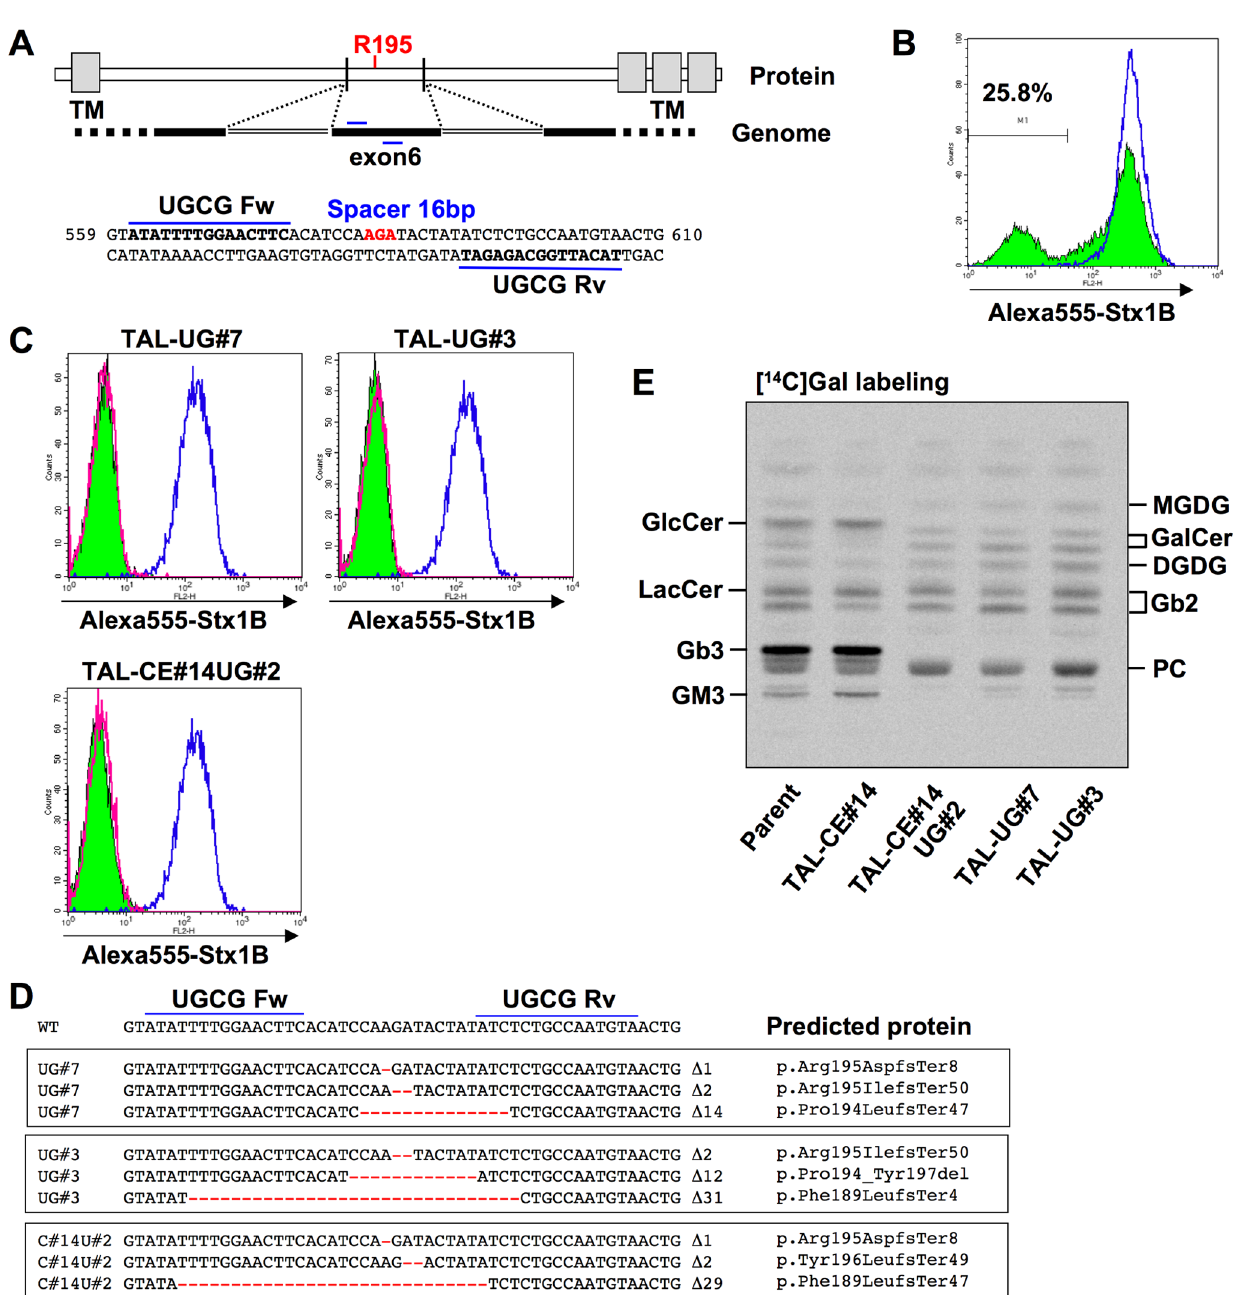
Figure 5. Isolation of UGCG -deficient and CERT/UGCG double-deficient clones. A, Target sites of TALEN-UGCG pair (TAL-ModA-UGCG) in human UGCG gene. The sequences are located in exon 6, which contains the codon of the 195th arginine (R195) essential for the activity. The target sites are shown in bold and the codon of R195 is shown in red. The numbers on the right and left of the sequence indicate the sequence numbers from the A of the translation initiation codon, based on UGCG mRNA (accession number D50840). B, Surface expression of StxRs on TALEN-UGCG– treated HeLa cells. HeLa cells were treated with TALEN-UGCG (colored histogram with black line) or empty vectors (blue line), and the cells were stained with Alexa-555-Stx1B. C, Surface expression of StxRs on TAL-UGCG clones (TAL-UG # 7 and # 3) and a TAL-CERT/UGCG clone (TAL- CE # 14UG # 2). The clones were stained with Alexa-555-Stx1 B (colored histogram with black line) or not (magenta line) and HeLa-mCAT # 8 cells were stained with Alexa-555-Stx1 B (blue line). D, Indel analysis of UGCG gene in TAL-UGCG (TAL-UG # 7 and # 3) and TAL-CE # 14UG # 2 clones. Deletions are shown in red and their lengths are specified on the right of the sequences. The predicted proteins are indicated based on the recommended description (see Materials and Methods) [50]. E, Metabolic labeling of lipids with radioactive galactose. TAL-UG # 7, -UG # 3 and -CE # 14UG # 2 cells were labeled with [ 14 C]galactose for 16 h, and lipids extracted from the cells were separated by HPTLC. Radioactive image of an analyzed TLC plate is shown. MGDG, monogalactosyl diacylglycerol; DGDG, digalactosyl diacylglycerol (Gal a 1-4GalDG); PC, phosphatidylcholine.